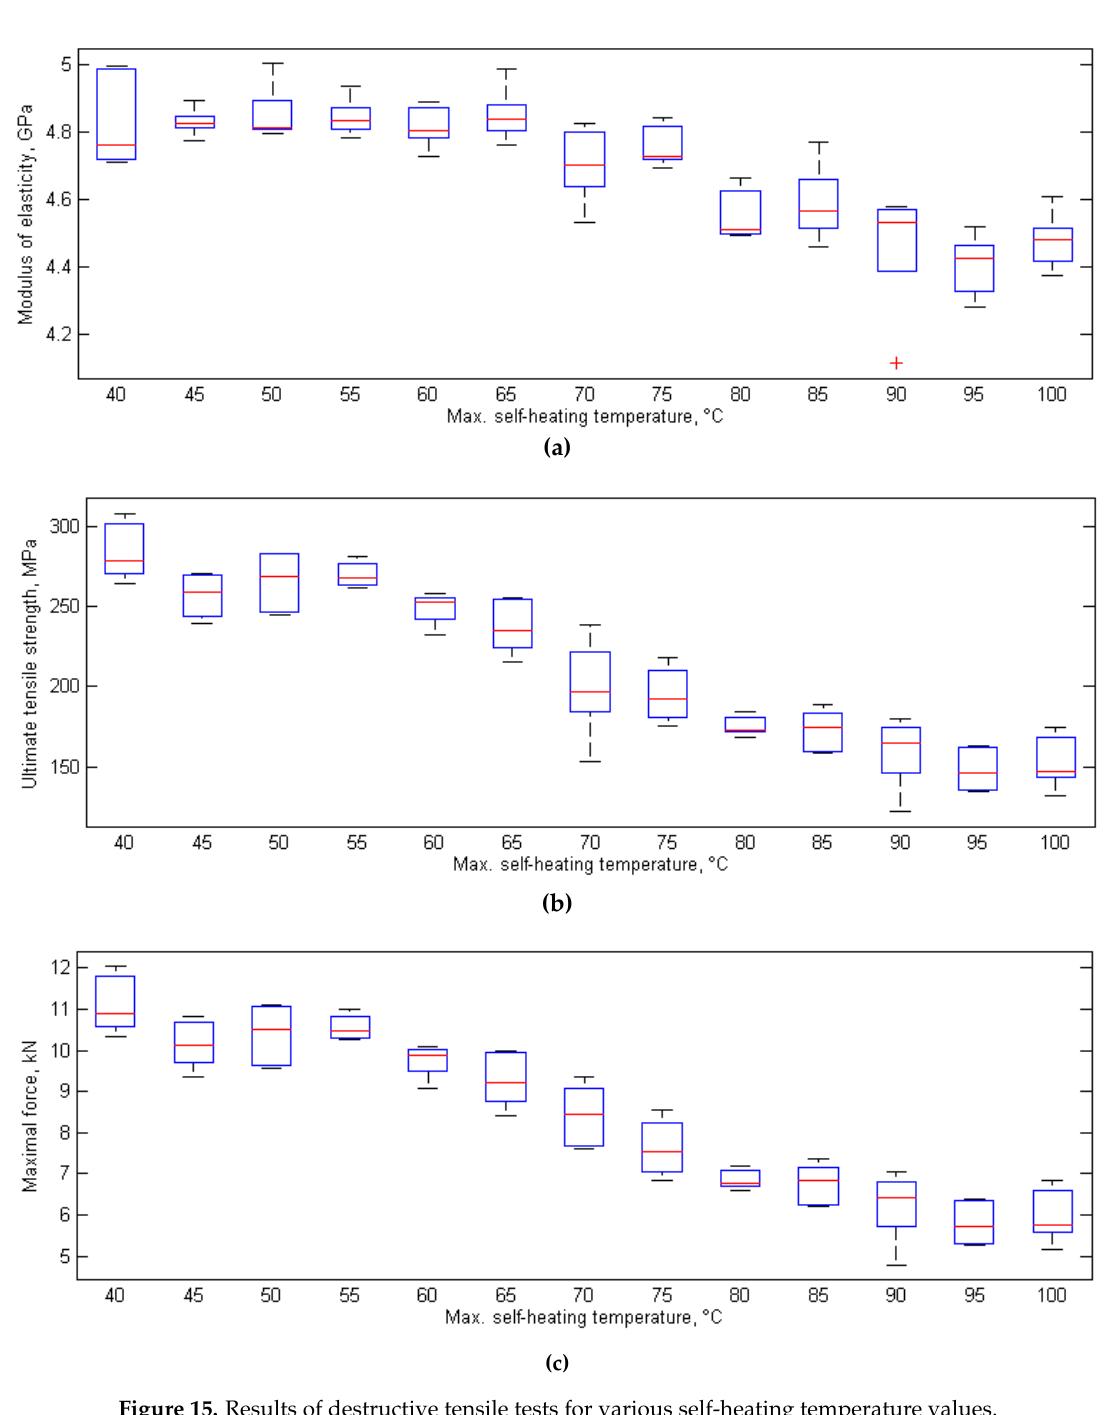
Figure 15. Results of destructive tensile tests for various self-heating temperature values.